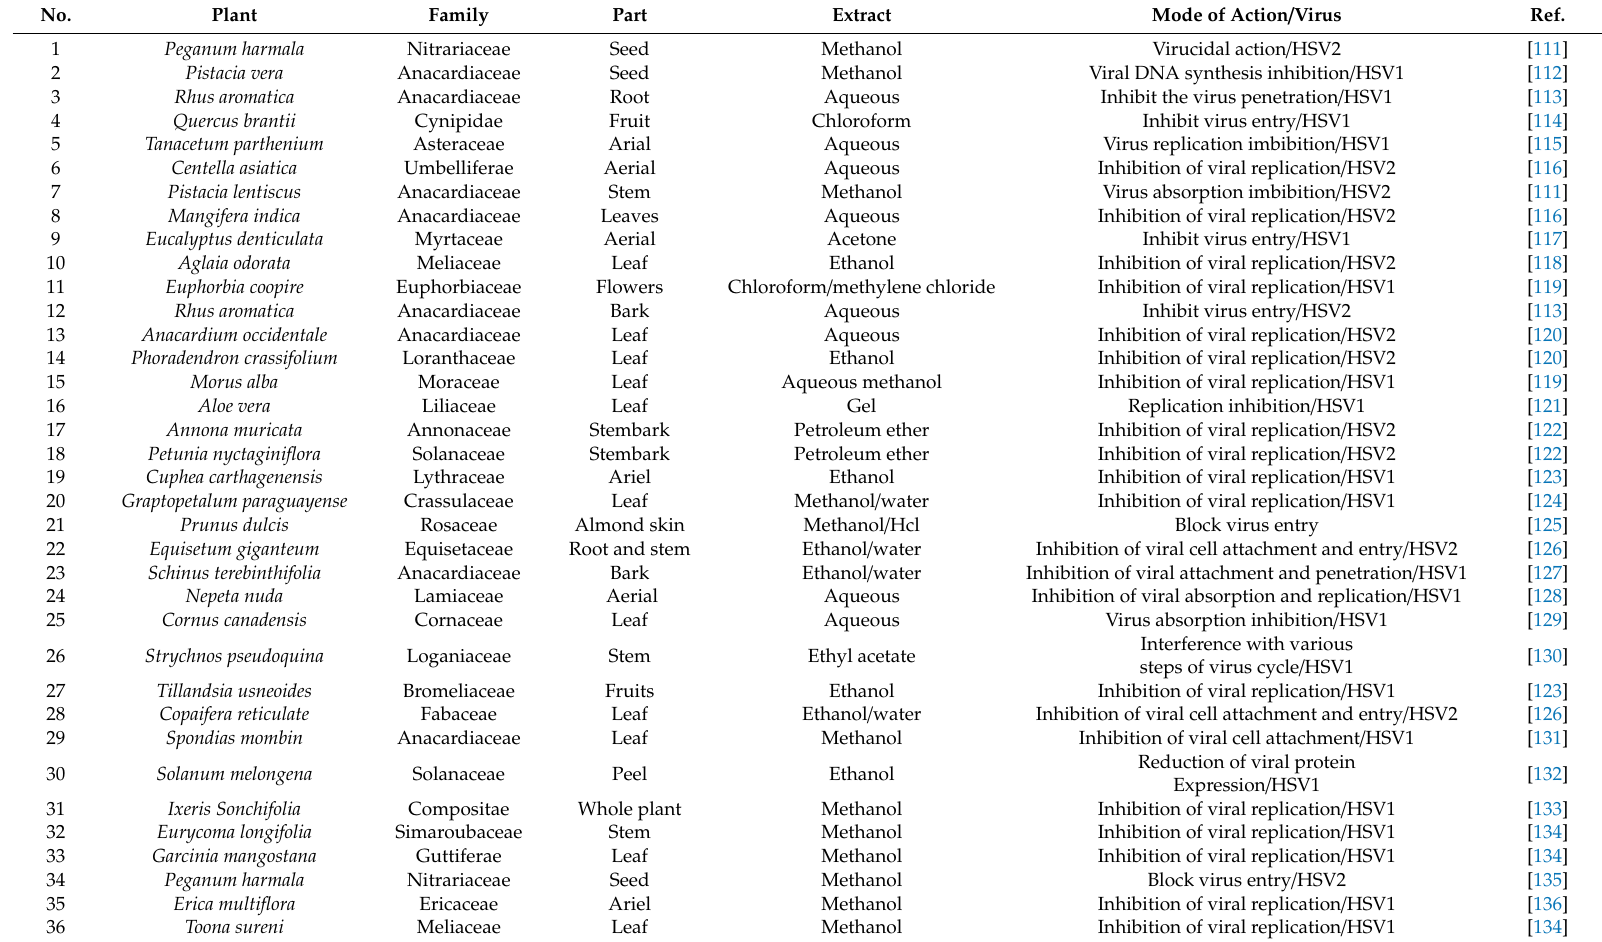
Table 3. Review of the plants that show anti-herpes simplex virus activities with their prospective family, part, type of extract, and inhibition target.